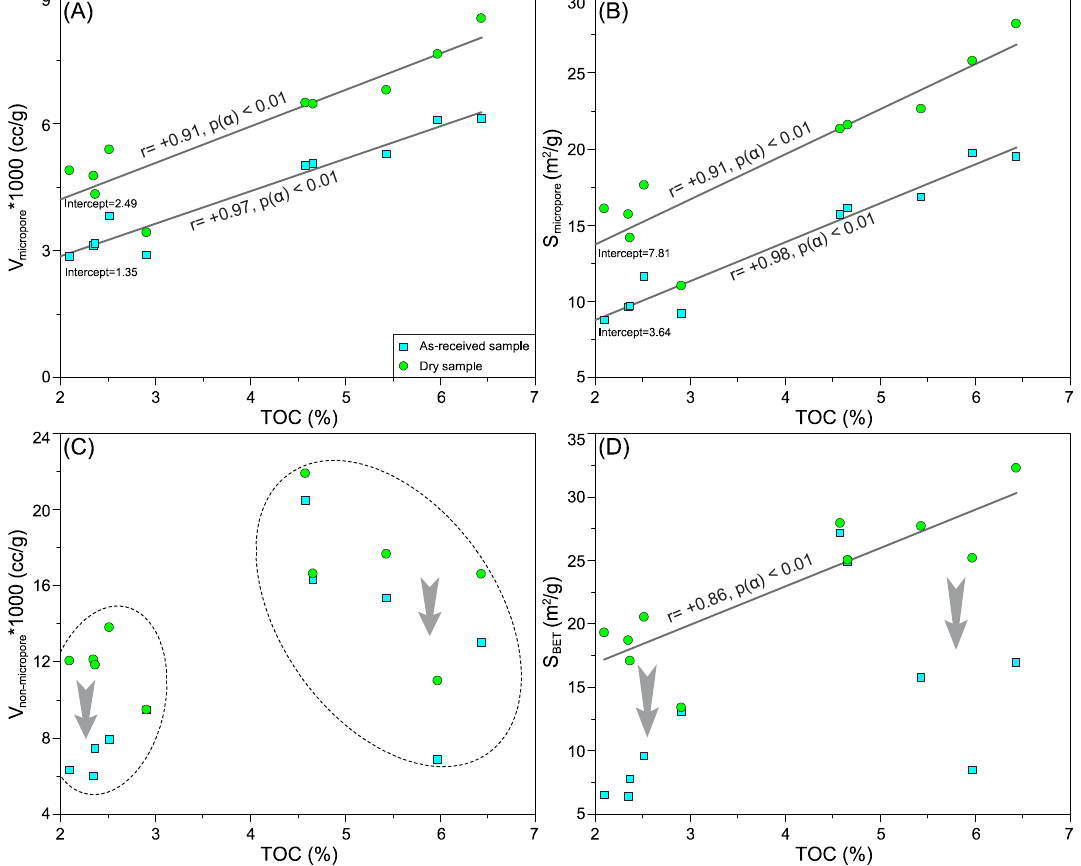
Figure 10. Cross-plots of the TOC content versus ( A ) V mic value, ( B ) S mic value, ( C ) V n-mic value, and ( D ) S BET value of the studied WF–LMX shales from the Well PS1.